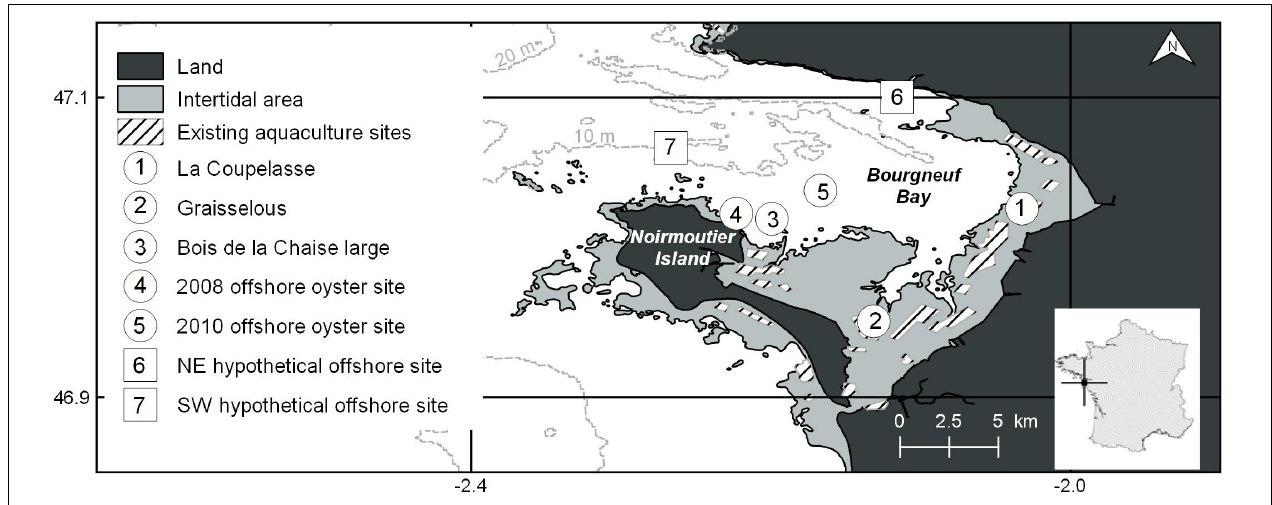
FIGURE 1 | The study site, Bourgneuf Bay, on the French Atlantic coast (indicated in subset). Intertidal (light gray) and offshore (white) zones, in addition to the locations of current aquaculture farms in the intertidal zone and in situ water and experimental oyster sampling sites are indicated.